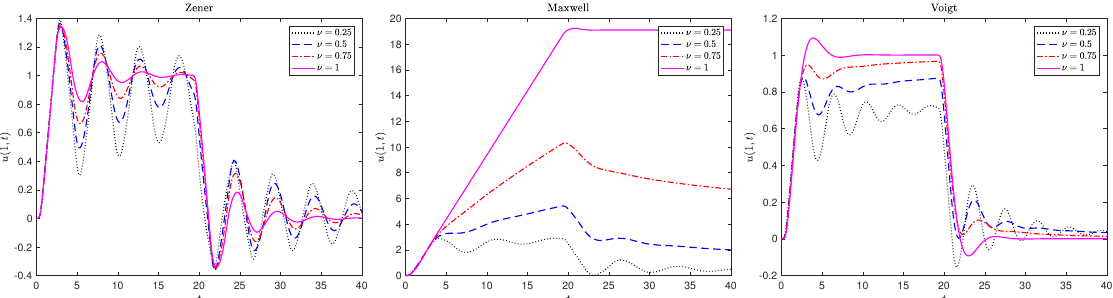
Fig. 4 Each plot shows the displacement of a 1D viscoelastic rod evaluated at the right endpoint, x = 1 for different values of ν . From left to right are the Zener, Maxwell, and Voigt models.